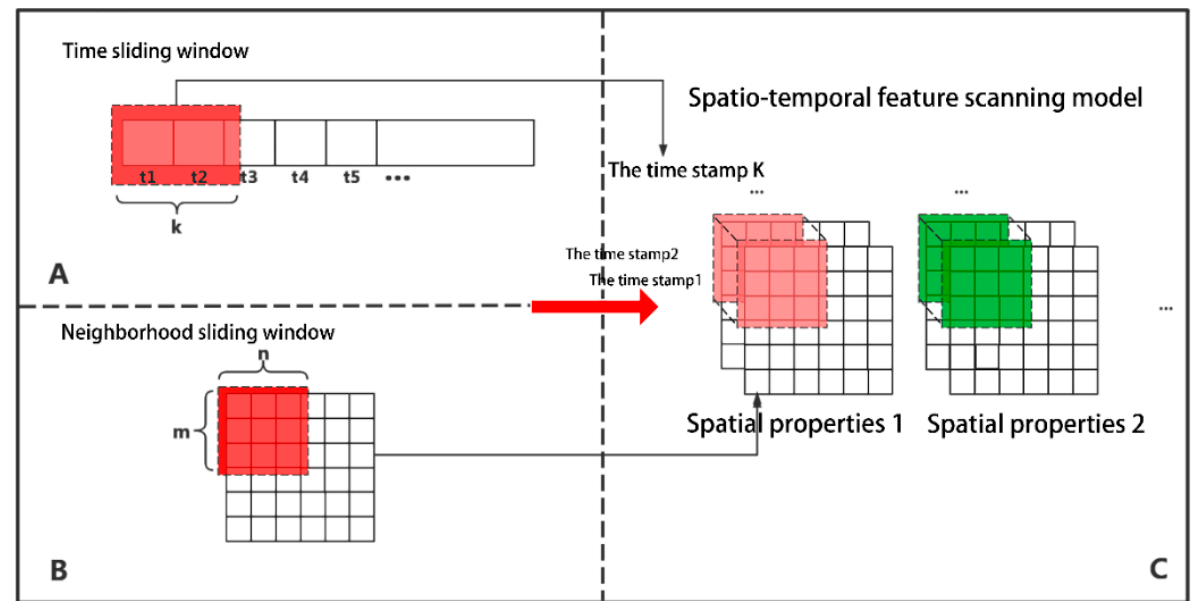
Figure 2. Spatio-temporal integration feature extraction model. ( A ) represents time feature extraction, ( B ) represents spatial features extraction, and ( C ) represents temporal and spatial features fusion. The red square in ( A ) represents the sliding window of time, the red square in ( B ) represents the sliding window of space. The pink and green squares in ( C ) represent sliding spatio-temporal windows for the two properties respectively.